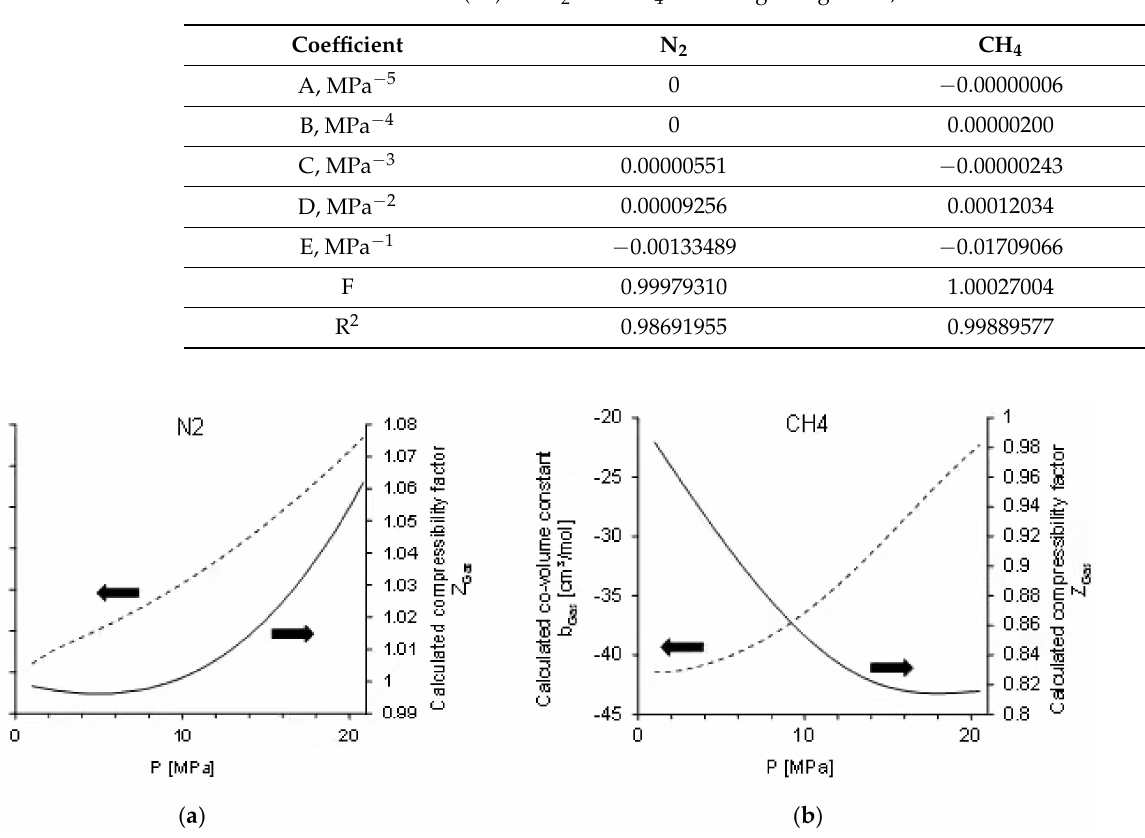
Figure 3. It can be seen that the absolute error between calculated and measured compress- ibility factors is less than 0.03 for the N 2 -H 2 mixture and less than 0.08 for the CH 4 -H 2 mixture at room temperature and the given pressure range. Such errors appear tolerable for engineering applications assessing hydrogen fugacities in mixed